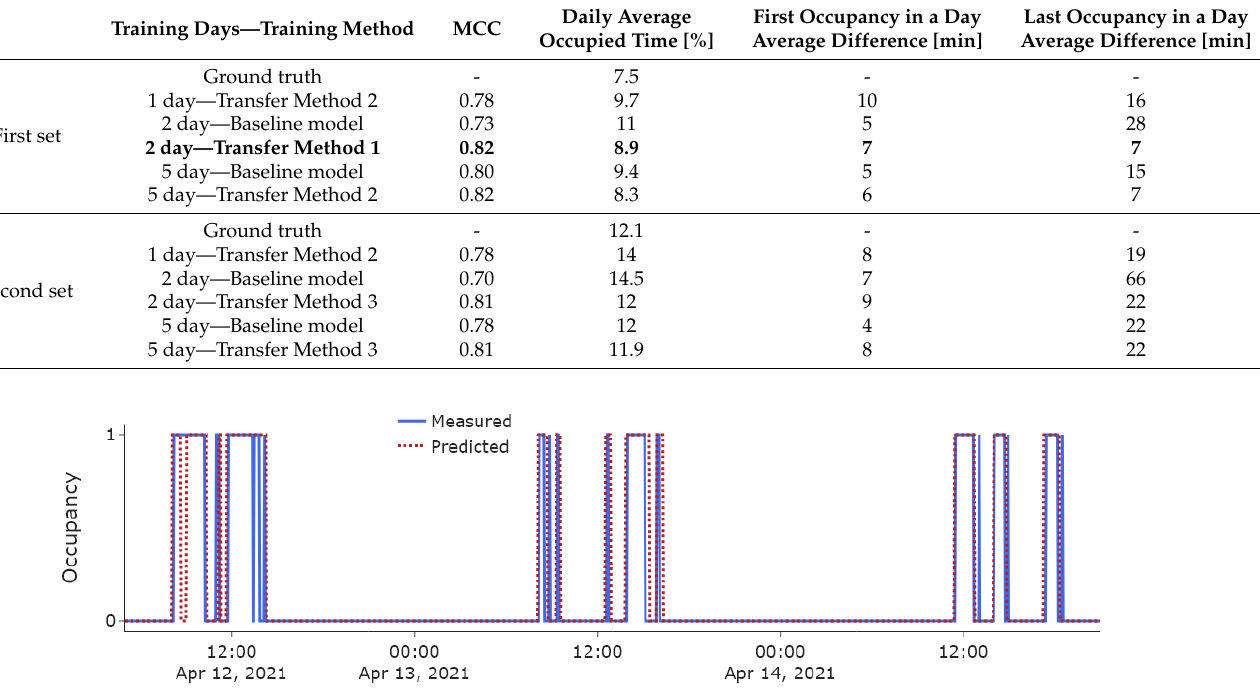
Figure 6. Three-day showcase of the selected target model performance and comparison with measured